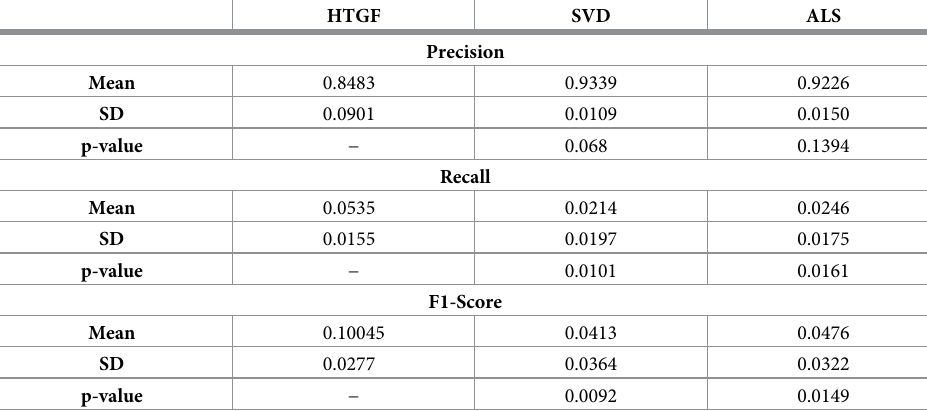
Table 18. Statistical comparison of HTGF with baselines.